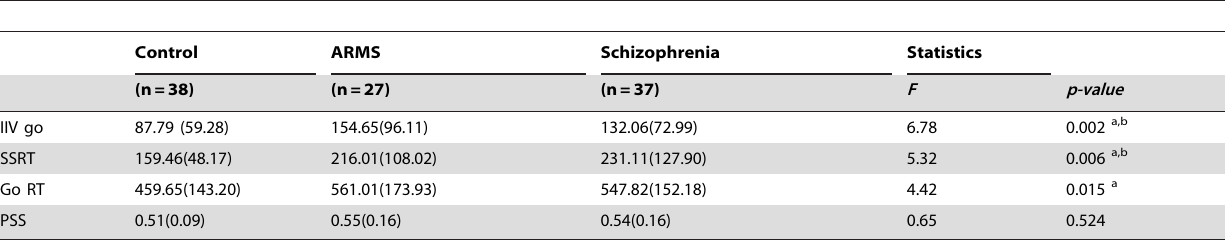
Table 2. Mean performance on the stop-signal task in normal controls, ARMS subjects and schizophrenia patients; these means were examined using